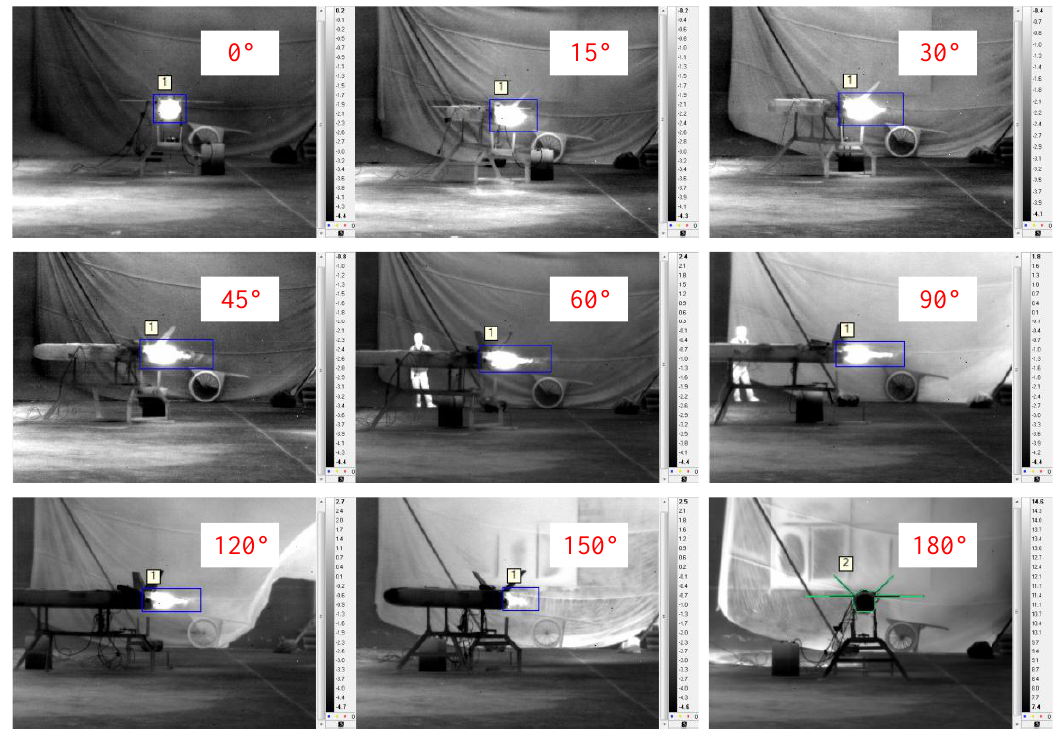
Figure 13. UAV images captured by the LWIR camera at different observation angles.